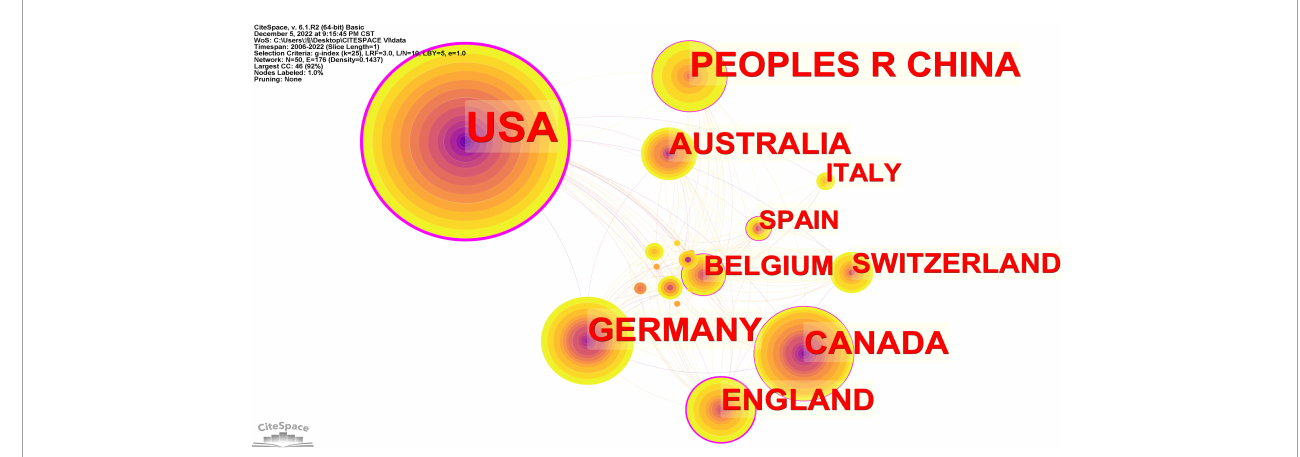
FIGURE5 A country cooperation map related to non-suicidal self-injury (NSSI) by CiteSpace. The large node is, the more publications output of countries is.